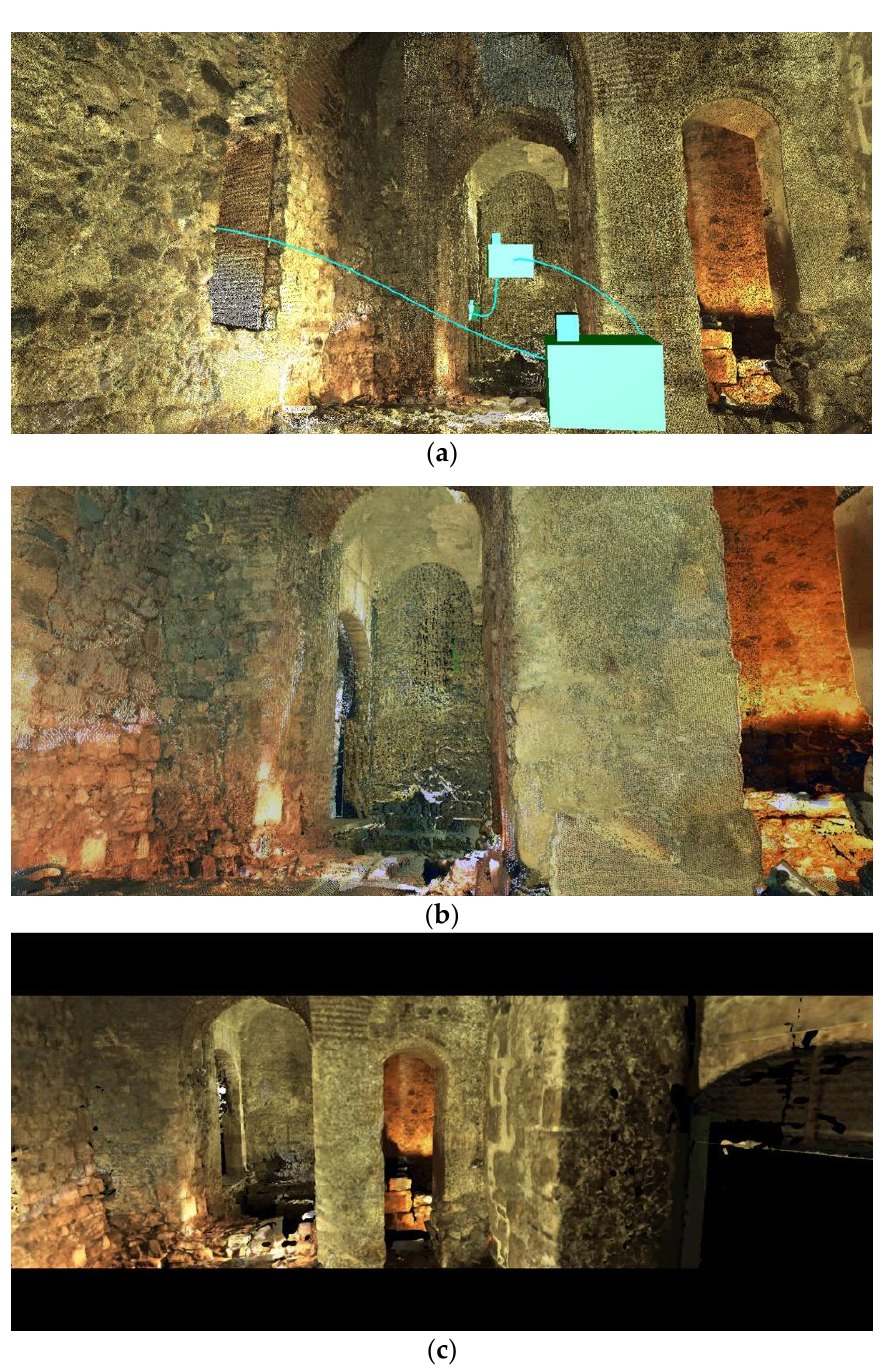
Figure 8. Virtual itineraries. ( a ) Virtual cameras and spline that generate the walkthrough. ( b ) Frame of the output obtained from point-cloud. ( c ) Frame of the video generated from the mesh.